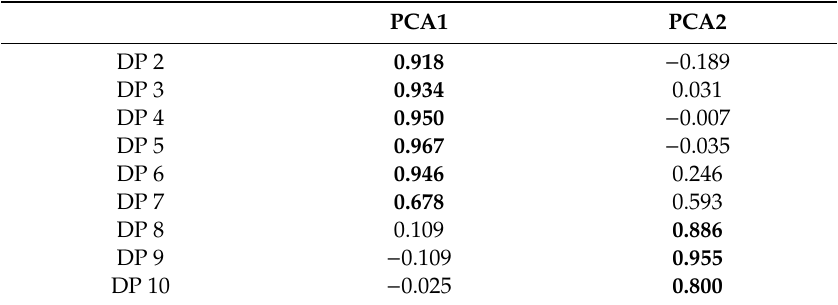
Table 2. Principal factor pattern for different degree of polymerization (DP) type.